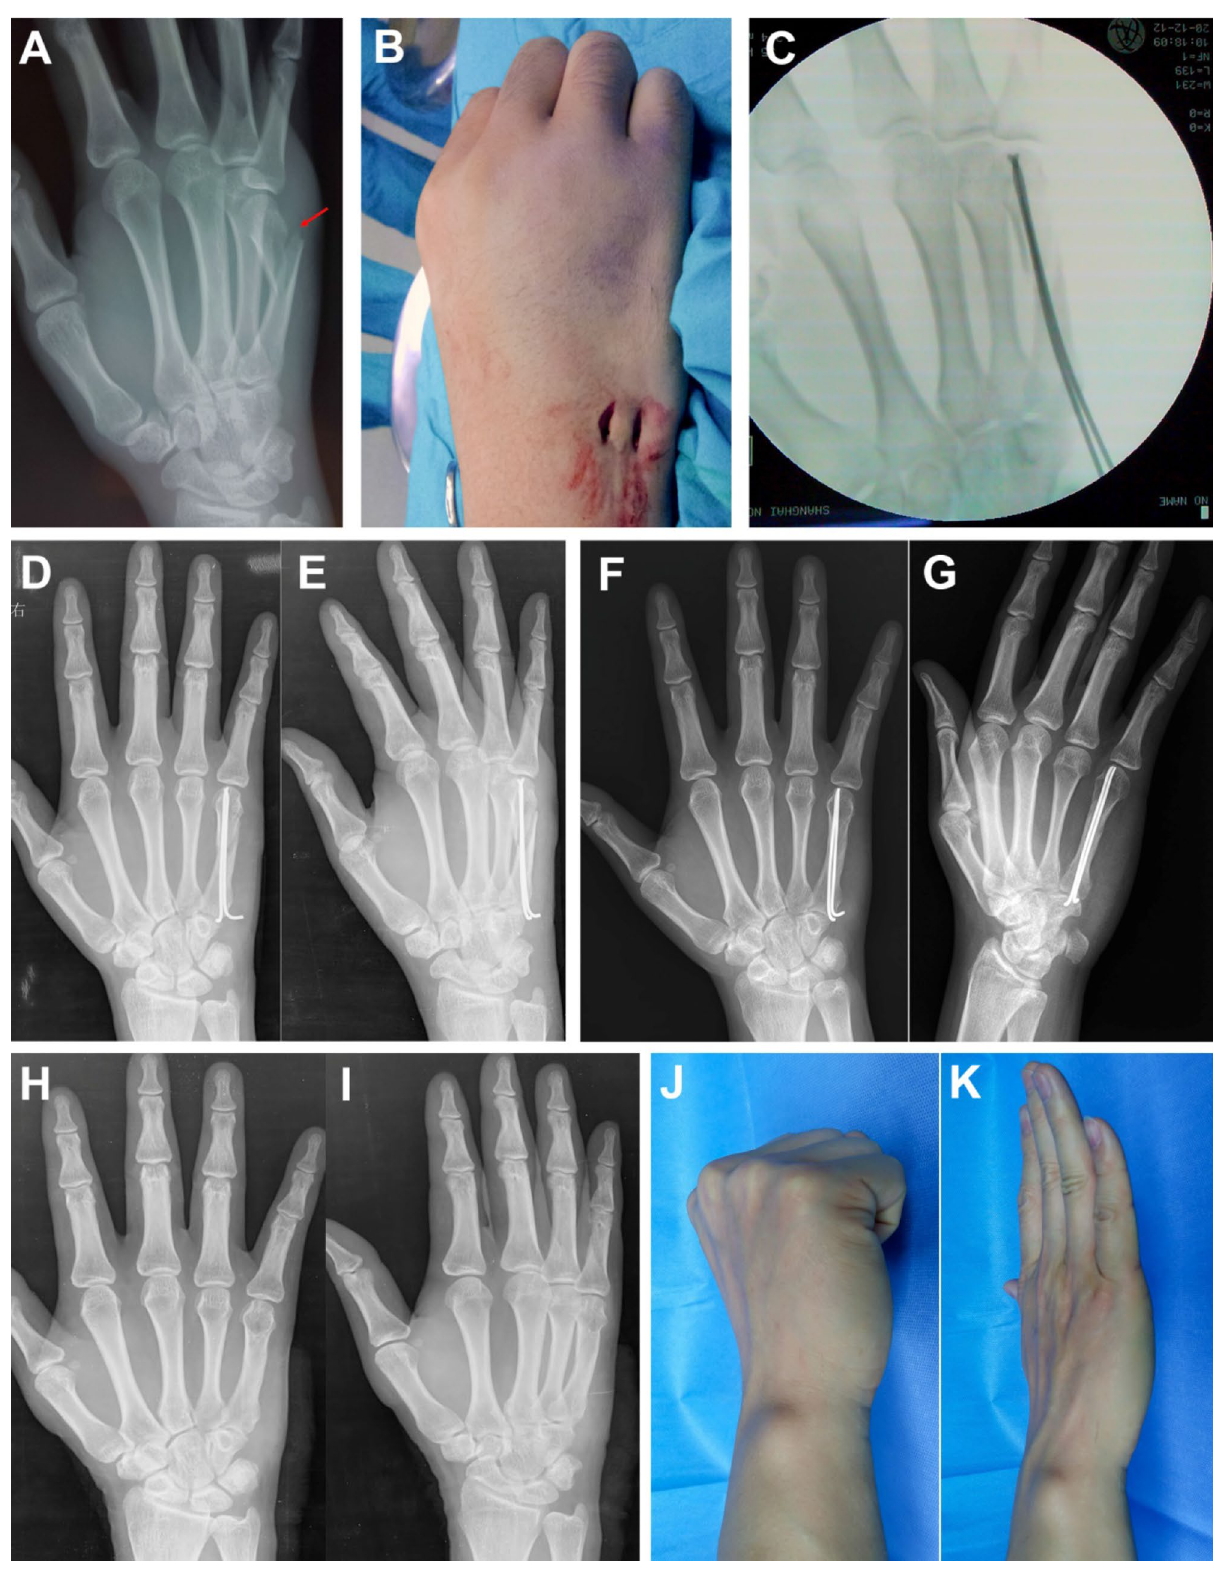
Figure 3. Clinical case of an FMNF treated by dual AEIMNs. Preoperative oblique view radiograph ( A ). Intraoperative photograph showing two incisions in the metacarpal base ( B ) . Intraoperative fluoroscopy ( C ). Postoperative radiographs showing good reduction of the fracture on the anteroposterior view ( D ) and oblique view ( E ) . Radiograph at 8 weeks after the operation shows union of the fracture ( F, G ). Radiograph at 6 months after removal of the nails ( H, I ). Photographs of the hand in flexion ( J ) and extension ( K ) at 12 months after